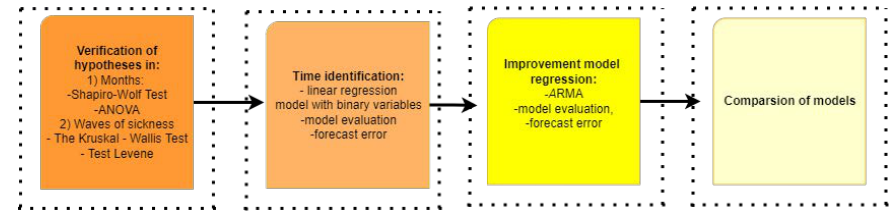
Figure 2. Research algorithm.